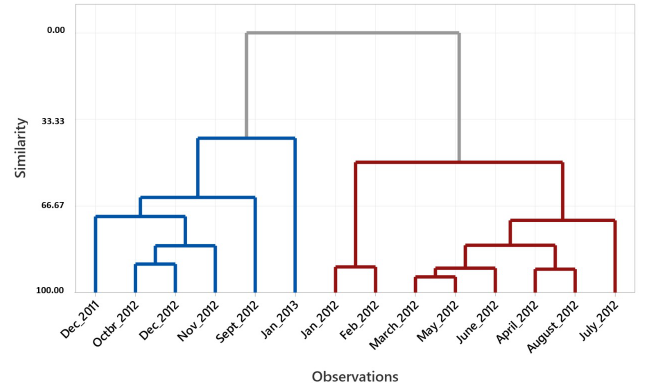
Figure 2. The Dendrogram plot shows that there are two groups of claim data